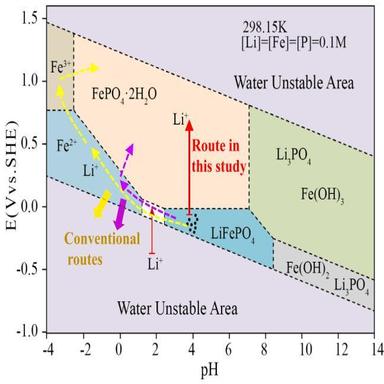
The E-pH diagram for Li-Fe-P-H2O system at 298.15 K.